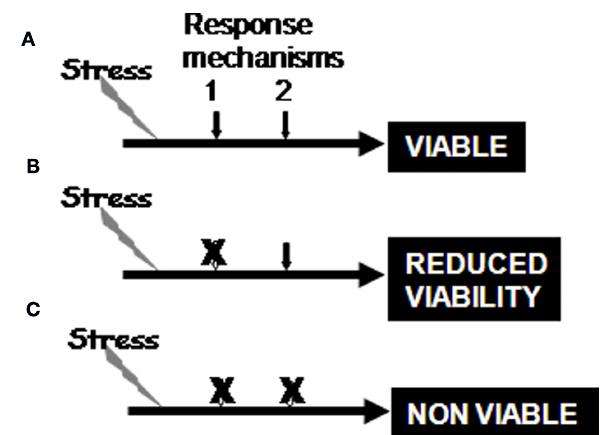
FIGURE 3 |The stress responses are functional in normal tissue (A), and loss of a stress response will reduce cell viability in the face of that stress and the cell become reliant on a secondary mechanism to adapt to the stress (B), whereas loss of primary response and the adaptation result in complete loss of viability (C). The loss of the secondary adaptation is known as synthetic lethality.